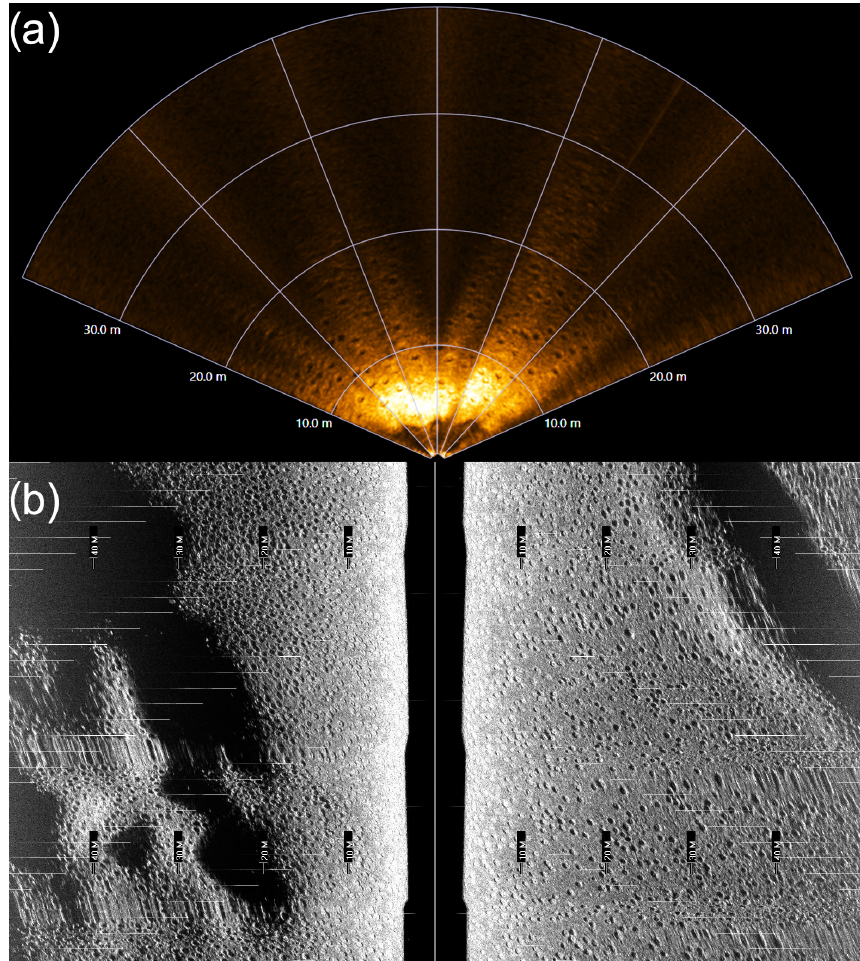
Figure 3. Raw acoustic data collected by the OFOBS during deployment PS124_63-1. Data show an area of the seafloor wholly covered by an array of actively nesting ice fish. (a) Forward-facing acoustic camera. (b) High-frequency side-scan sonar data. An area of slightly undulating seafloor is wholly covered with actively nesting ice fish. The white, bright reflectors within the centre of many of the ice fish nests indicate the presence of a brooding